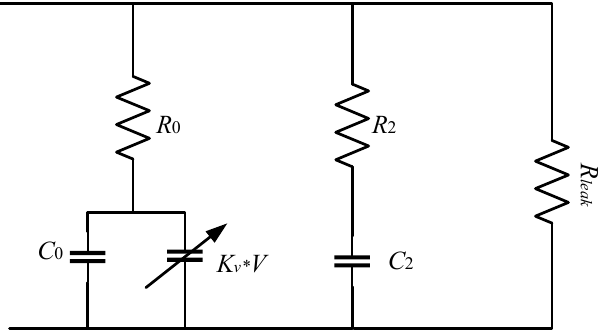
Figure 12. The two-branch model of DLCs showing the configuration of the two RC branches.